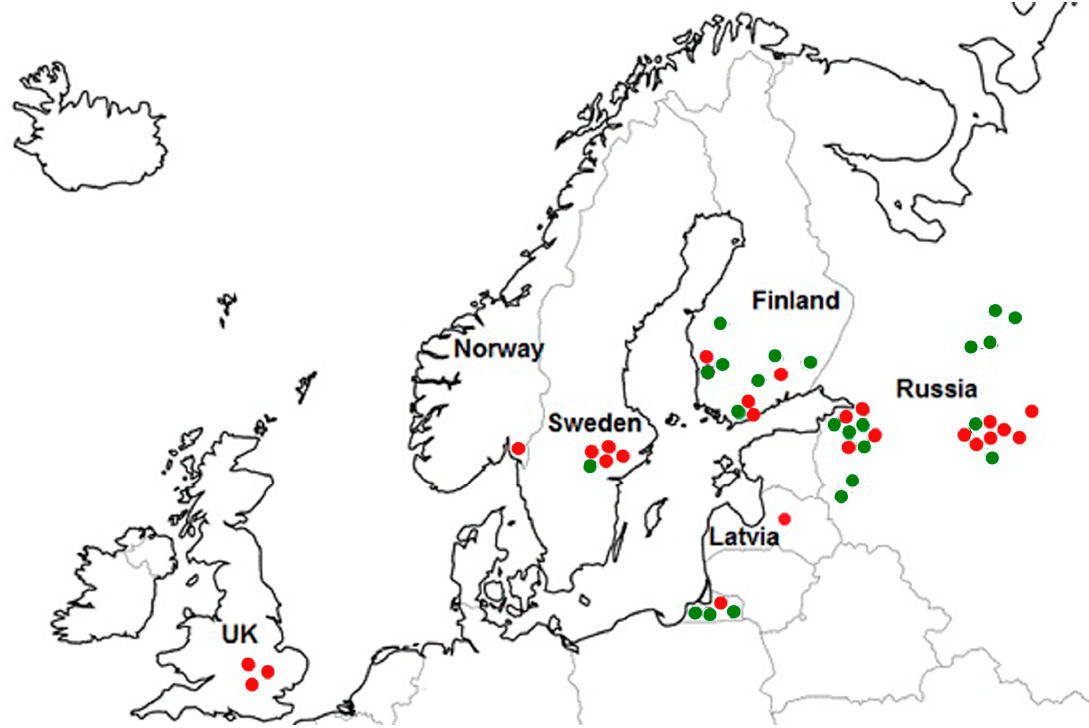
Figure 1. The origin of F. langsethiae strains belonging to different subgroups: • (green dots)—subgroup I; (red dots)—subgroup II.